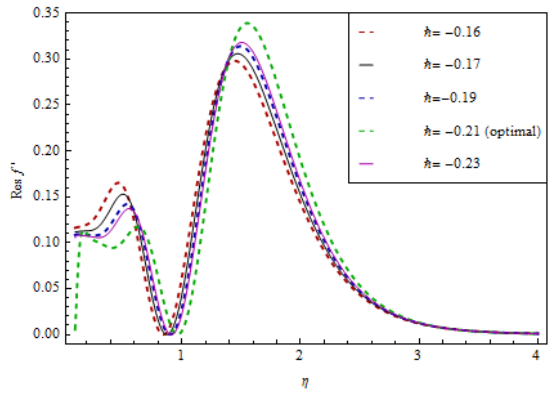
Fig. 3: Residual error for non-dimensional velocity for alumina- sodium alginate nanofluid with A = 0.5, M = 1, U 6.2, ϕ = 0.2, λ = 1.